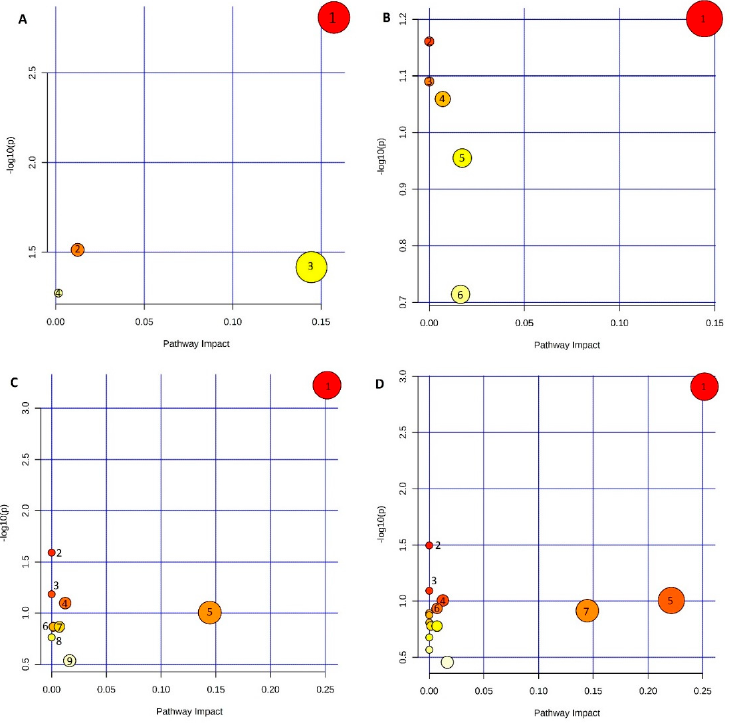
Figure 3. Metabolic pathway analysis performed for metabolites significant in different comparisons: 0 vs. 6 (panel A ), 0 vs. 9 (panel B ), 0 vs. 12 (panel C ), and 0 vs. 18 (panel D ). Pathway